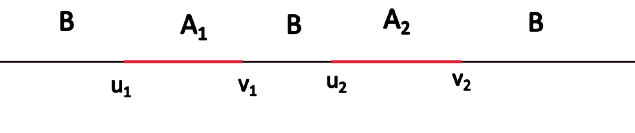
Figure 1 . Two disjoint intervals, intervals A 1 and A 2 are ( u 1 , v 1 ) and ( u 2 , v 2 ) respectively, here ‘ 1 = | v 1 − u 1 | , ‘ 2 = | v 2 − u 2 | and d = | u 2 − v 1 |